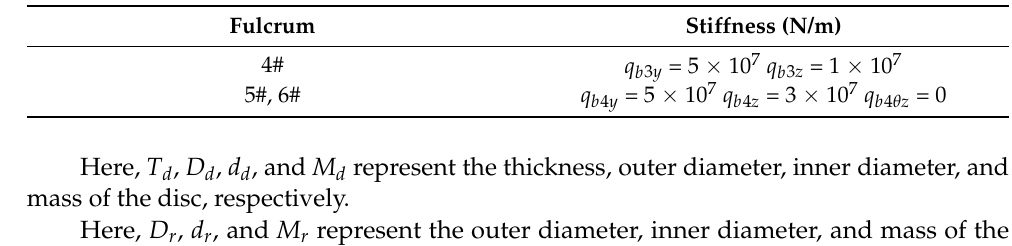
Table 4. Stiffness of front fulcrum and back fulcrum of the high-pressure rotor